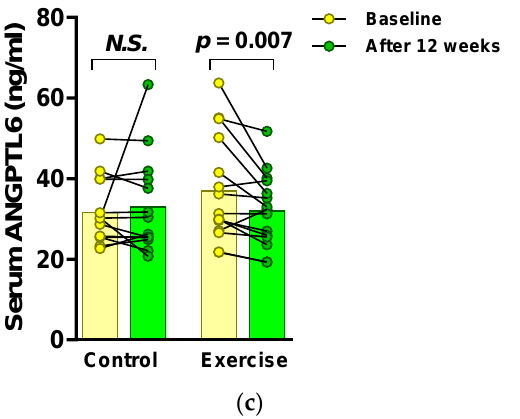
Figure 3. Individual and mean changes in circulating levels of ( a ) fibroblast growth factor 21 (FGF21), ( b ) growth differentiation factor 15 (GDF15), and ( c ) angiopoietin-like 6 (ANGPTL6) elicited by a 12-week exercise training in metabolic syndrome patients. Circles and bars represent individual data and the means, respectively. p -values were determined by Wilcoxon signed-rank test (for FGF21 and ANGPTL6) or Student’s paired t -test (for GDF15). N.S., not statistically significant.